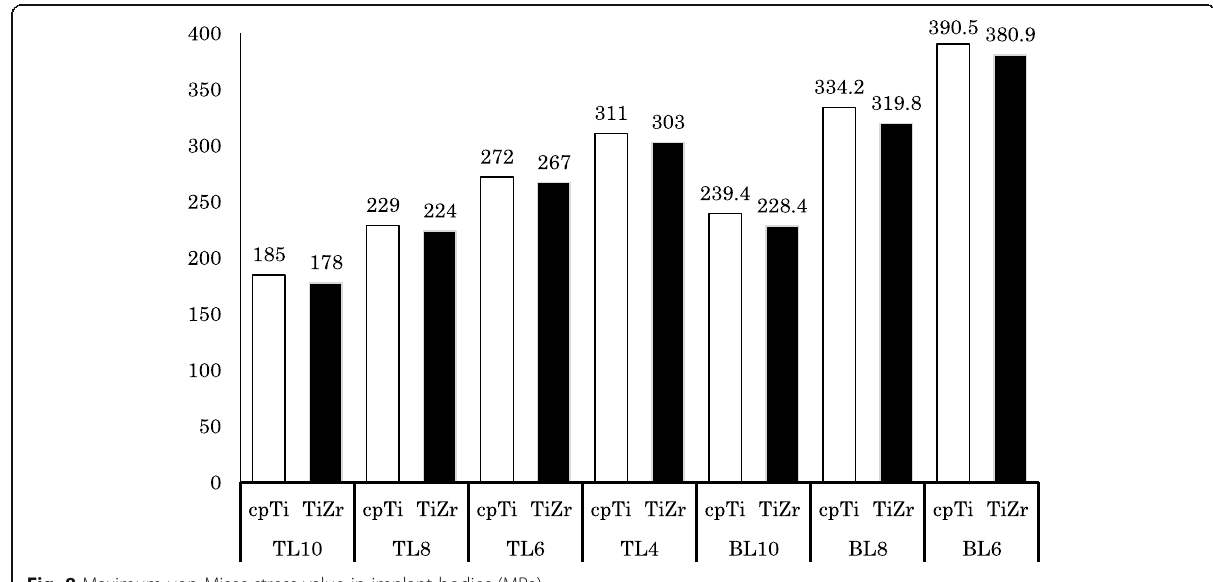
Fig. 8 Maximum von Mises stress value in implant bodies